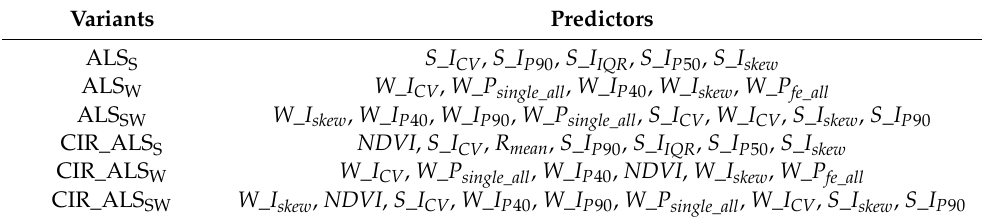
Table 6. The most important predictors in the classification variants. The ALS is the point cloud from the leaf-on (S) or/and leaf-off (W) season, whereas the CIR is the spectral information derived from the colour-infrared images. The descriptions of the predictors and variants are included in Tables 3 and 4,